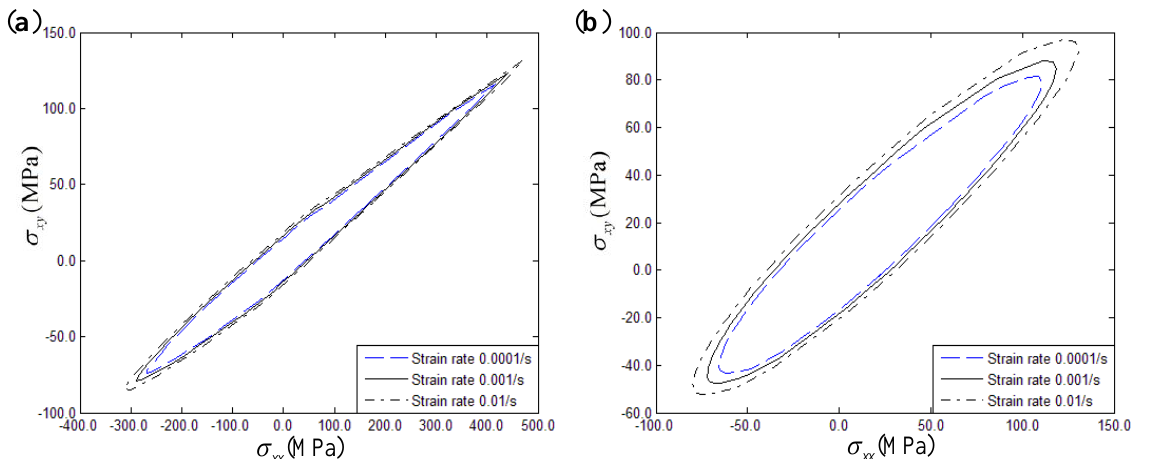
Figure 13. Strain rate influence on yield surface of composites: ( a ) 15° fiber-reinforced composites; ( b ) 30° fiber-reinforced composites; ( c ) 45° fiber-reinforced